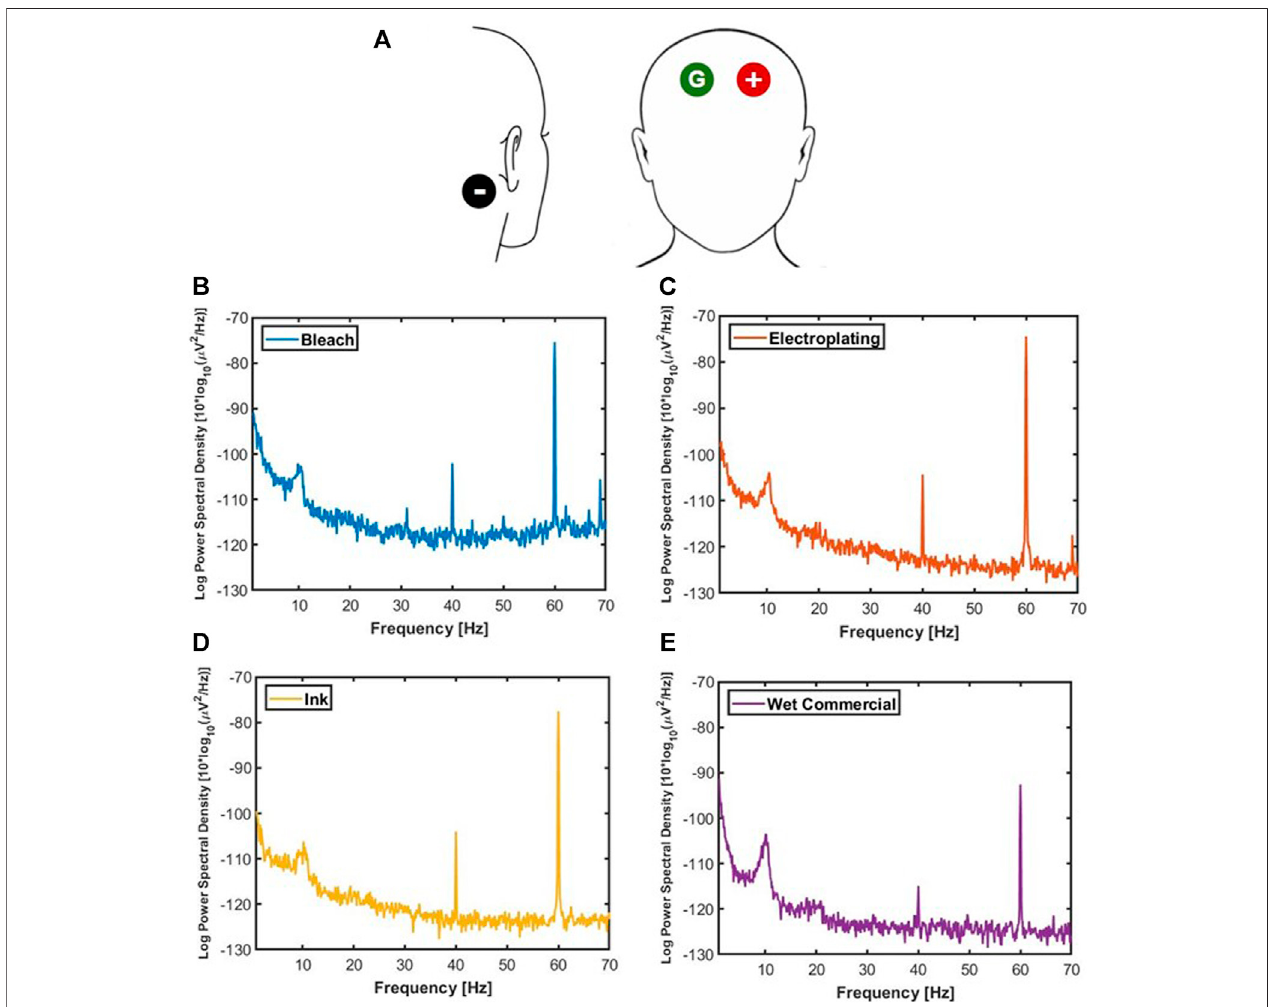
FIGURE4|(A) HeadoutlinewithelectrodeplacementfortheASSR.Theaveragelogpowerspectraldensityofbleach (B) ,electroplating (C) ,ink (D) ,andwetcommercial (E) .